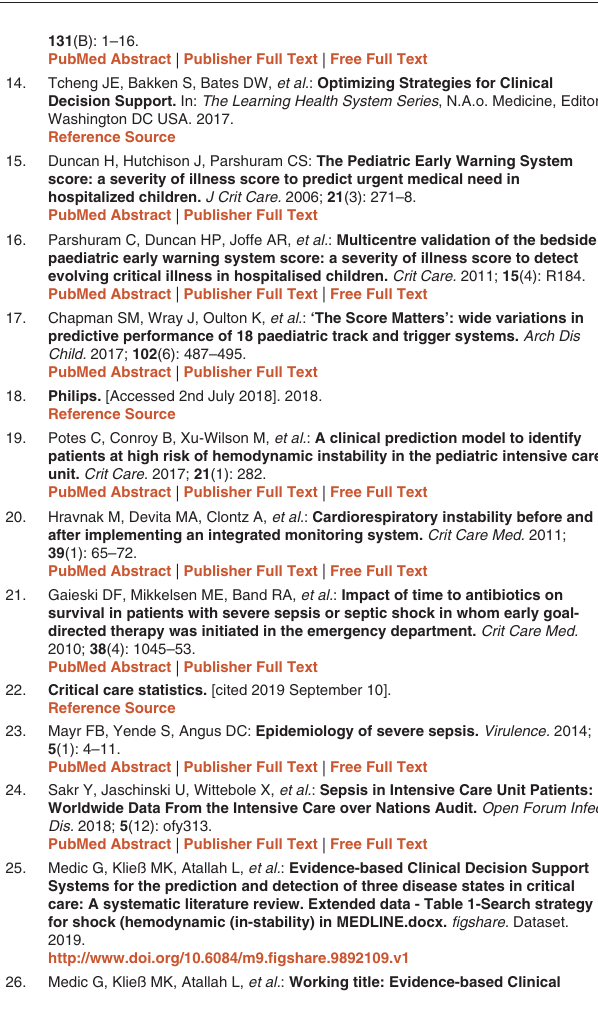
Figshare: PRISMA checklist for ‘Evidence-based Clinical Deci- sion Support Systems for the prediction and detection of